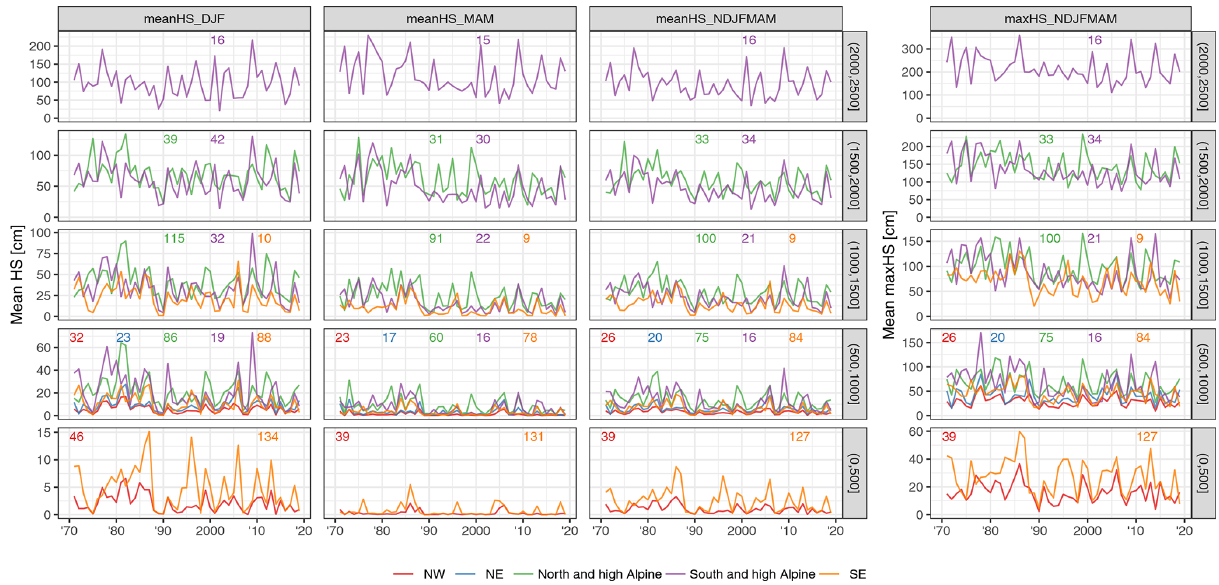
Figure C3. Time series of mean seasonal snow depth (HS) indices averaged by 500m elevation bands. The rows indicate elevation band and the columns the index. The season is indicated in the columns with the first letter of the included months (e.g. DFJ is December, January, and February). The small numbers at the top of each panel denote the number of stations included in the average. Lines are only shown if more than five stations were available.